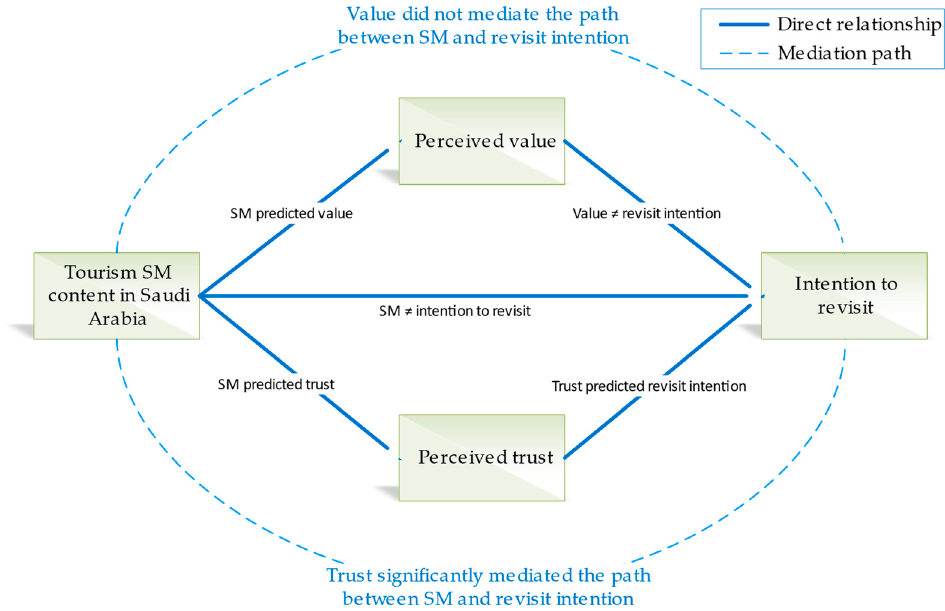
Figure 3. Results of the applied model. SM: social media.